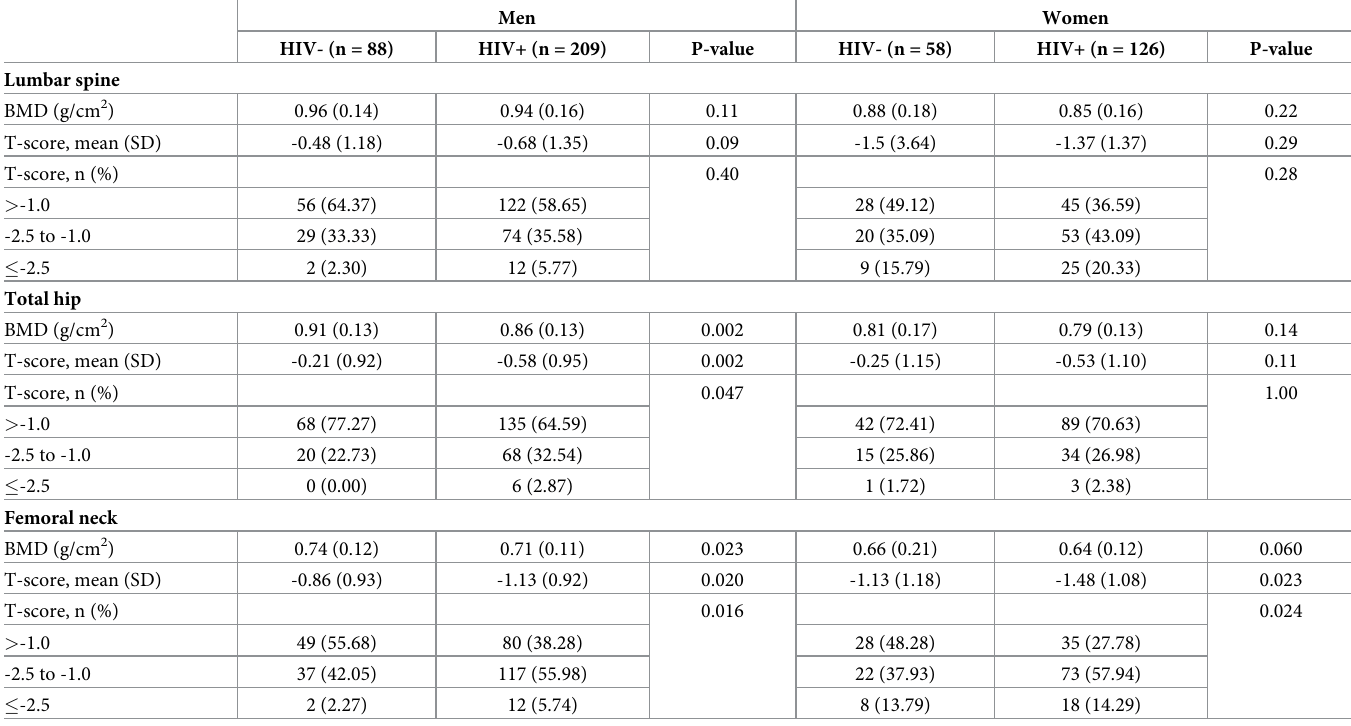
Bone mineral density at the lumbar spine, total hip and femoral neck Unadjusted BMD (grams per square centimeter) of the total hip and femoral neck were signifi- cantly lower in HIV+men than HIV- men, while differences among women were not statisti- cally significant (Table 2). No difference in the vertebral BMD was observed in either men or Table 2. Unadjusted BMD and T-score at the lumbar spine, total hip and femoral